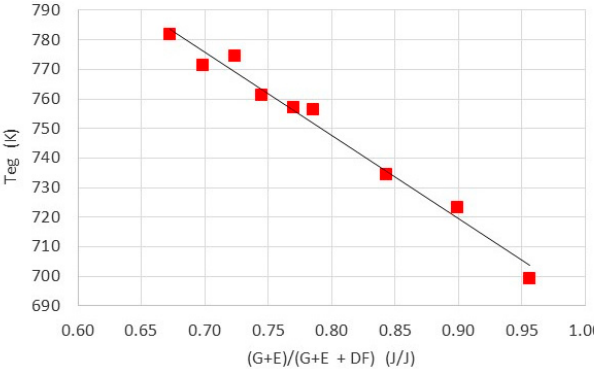
+ E fraction by energy content. Energies 2020 , 13 , 6349